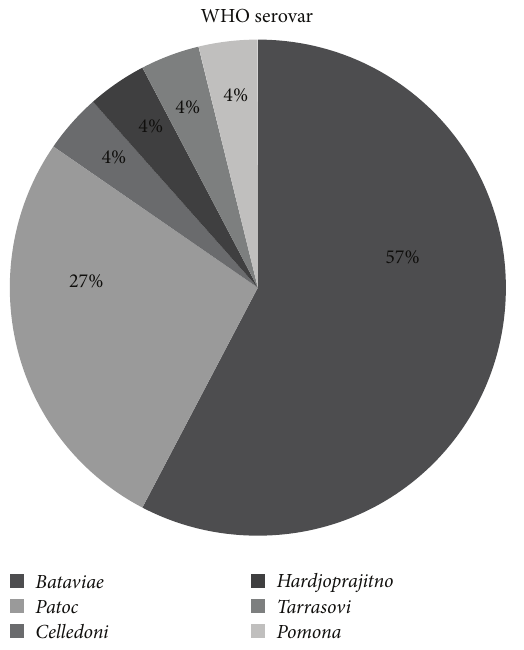
Figure 2: Serovar (WHO) among seropositive municipal service workers.